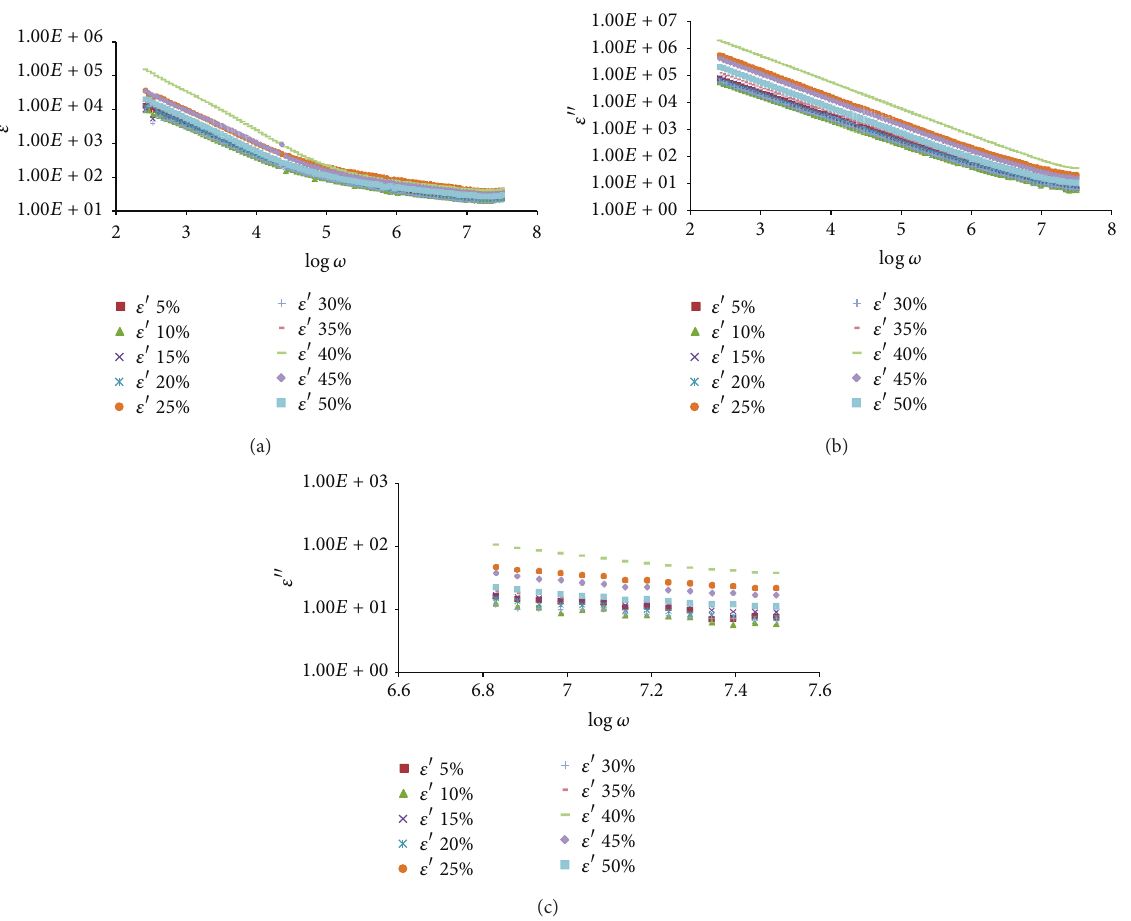
Figure 5: Variation of (a) real part and (b) imaginary part of dielectric parameter with frequency. (c) Extended view of (b) at higher frequency for NaI.